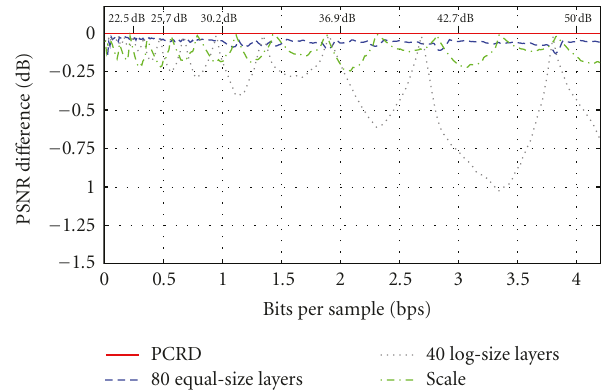
Figure 4: Coding performance evaluation between SCALE and two common allocation strategies distributing quality layers logarithmi- cally and uniformly spaced in terms of bitrate, for the candle image (color,